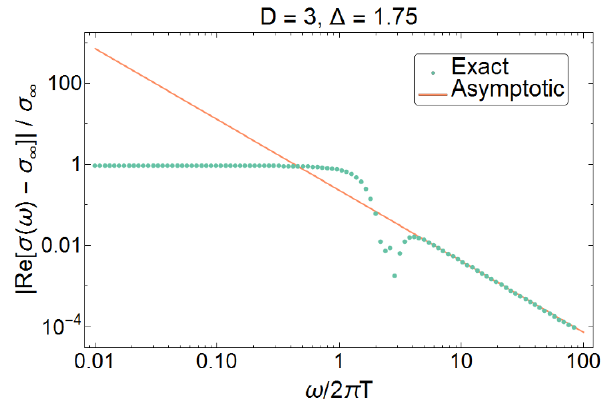
Figure 8 . Comparison of Re[ (cid:27) ( ! ) (cid:27) 1 ] between our analytic prediction (1.3) for the subleading (cid:0) correction to the conductivity, and the full dynamical conductivity at (cid:11) Y (cid:11) Z = (cid:24) = 1 in D =3.